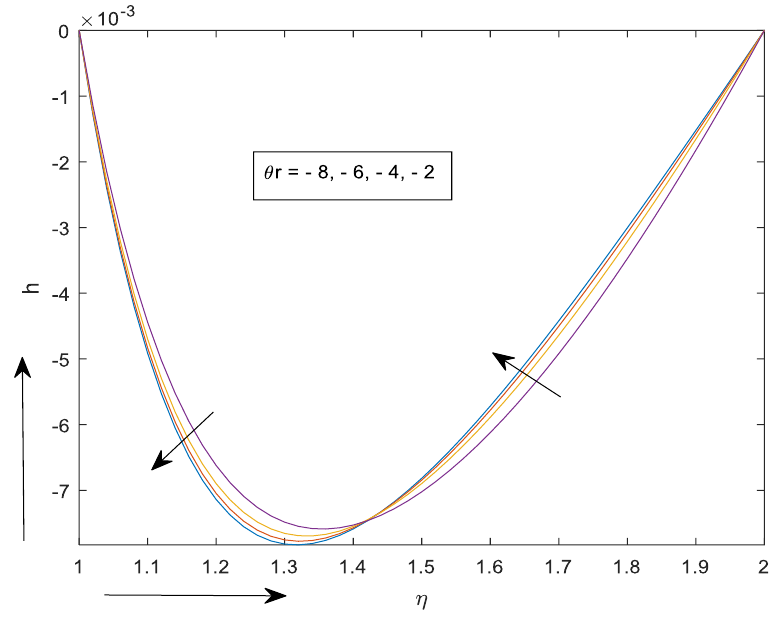
Figure 11. Angular velocity profile for different values of 𝜃